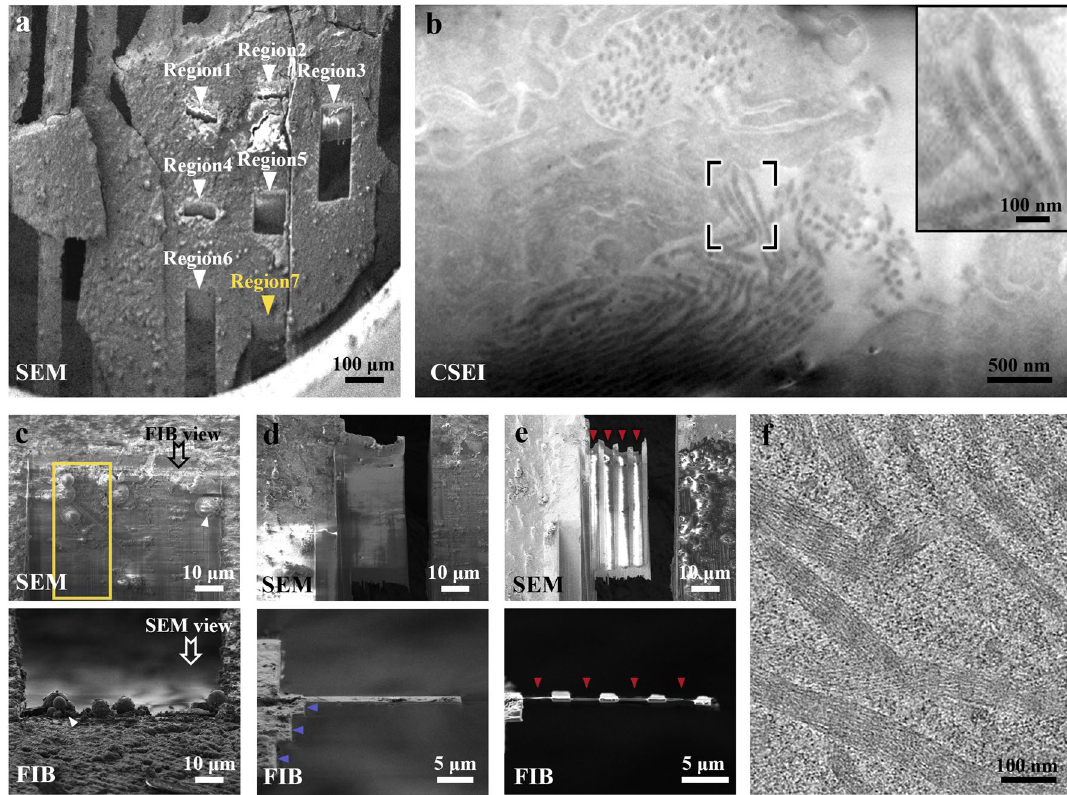
Figure 6. Complete workflow illustrated using a mouse liver sample. ( a ) Pre-sectioned and frozen liver slice under SEM view. Seven regions (arrows) were created for CSEI-based localization. ( b ) Region 7 in ( a ) was viewed by CSEI, showing the target collagen fibrils. The inset image shows magnified fibrils in the black box. ( c ) The top surface of the lamella was milled during CSEI-based localization. The yellow box is the target area. Ice contamination (white arrows) was produced when transferred to another cryoFIB instrument for further milling. ( d ) The liver tissue was coarsely milled to reduce the target area to ~ 1 µm thick. Blue arrows show the stepped edge on one side of the lamella. ( e ) The final lamella after fine milling. Red arrows show the furrows. ( f ) A section-view of a tomogram showing collagen fibrils (Supplementary Movie 2). The imaging method, SEM or FIB, is labeled in the bottom-left of each panel. Crossbeam 550 (ZEISS Microscopy) was used for CSEI-based localization; Helios (FEI Company) was used for further cryoFIB milling